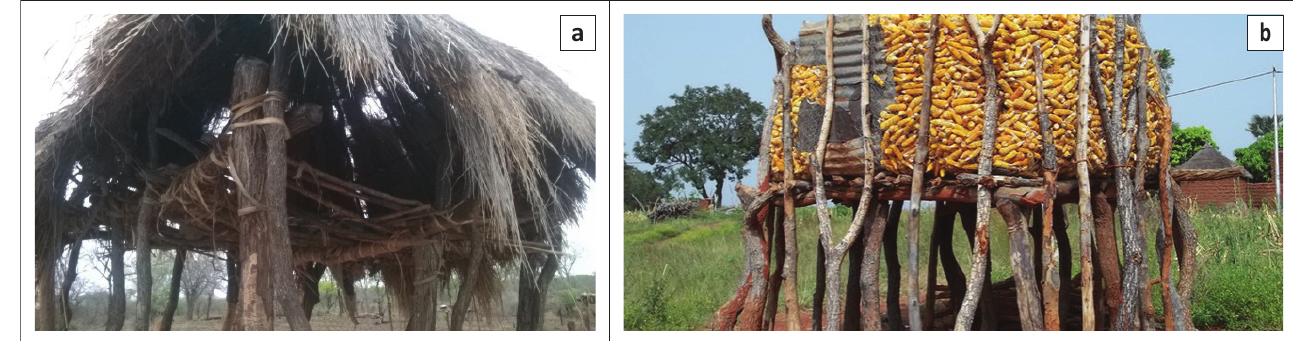
FIGURE 5: Multipurpose structures raised above the flood-predicted level. (a) Raised tower structure (b) Raised structure for storing